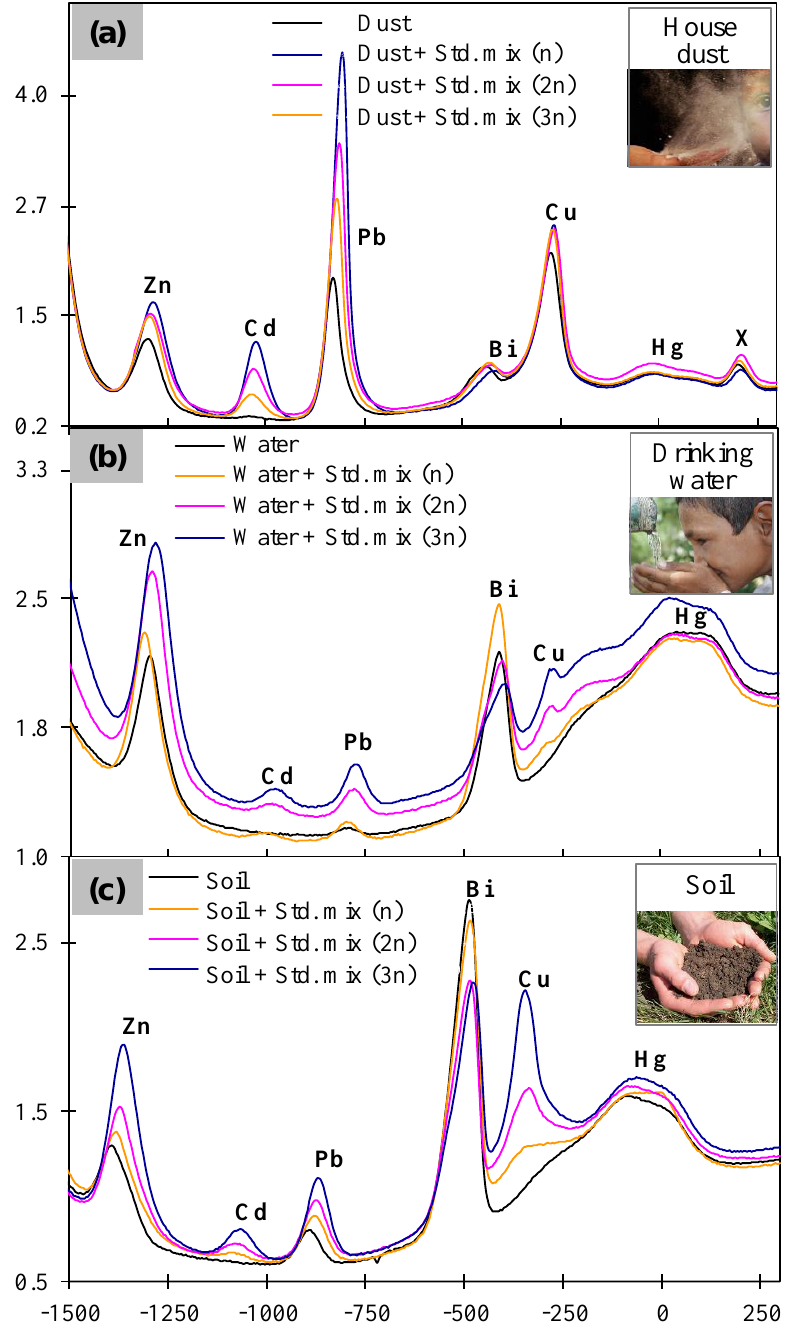
Figure 4. Simultaneous electrochemical measurement of various heavy metals in real samples using the “DEP-On-Go” system. DPV curves are shown for the simultaneous detection of zinc, cadmium, lead, copper, and mercury in real samples from house dust ( a ), drinking groundwater ( b ), and soil ( c ). Std. mix = Standard mixture (see Section 2.3).